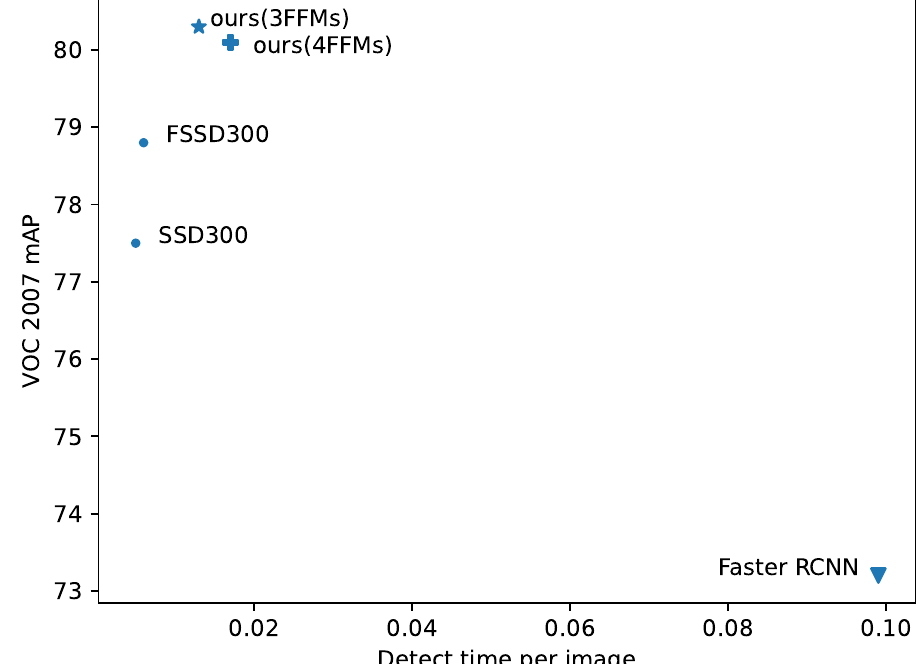
Figure 4. Comparison on detect time of each image. In the figure, 3FFMs indicates the model which adopts 3 feature fusion modules, while 4FFMs applies 4 feature fusion